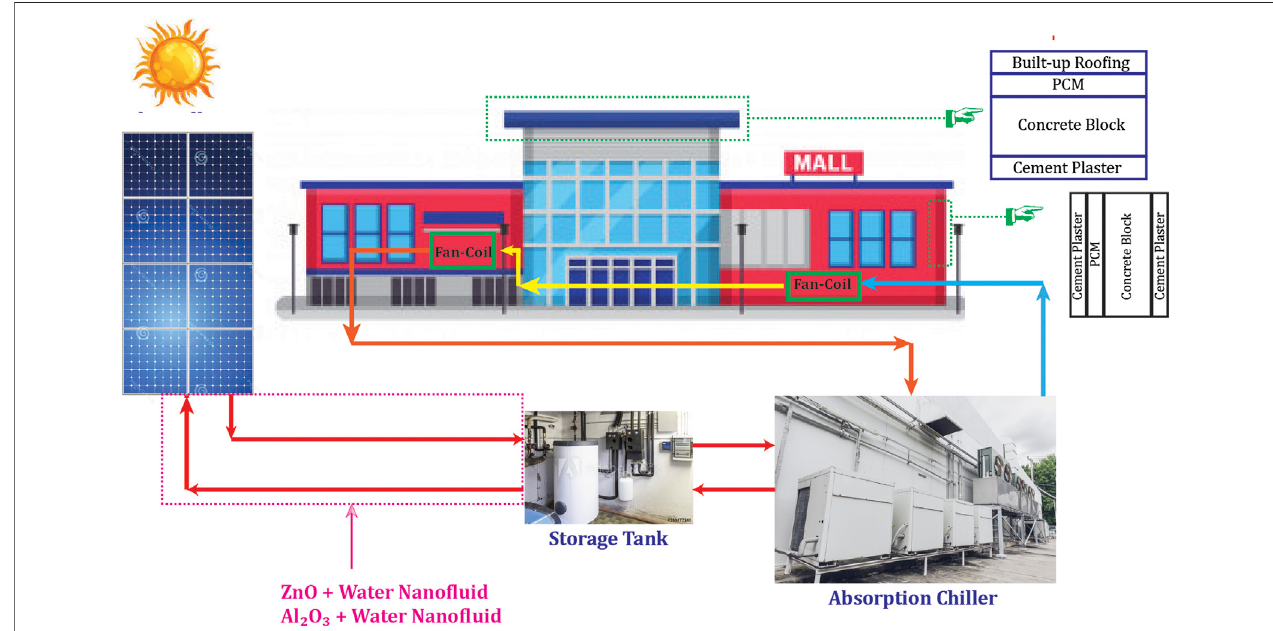
FIGURE 1 | PCM-based building integrated with a nano fl uid fi lled solar system.